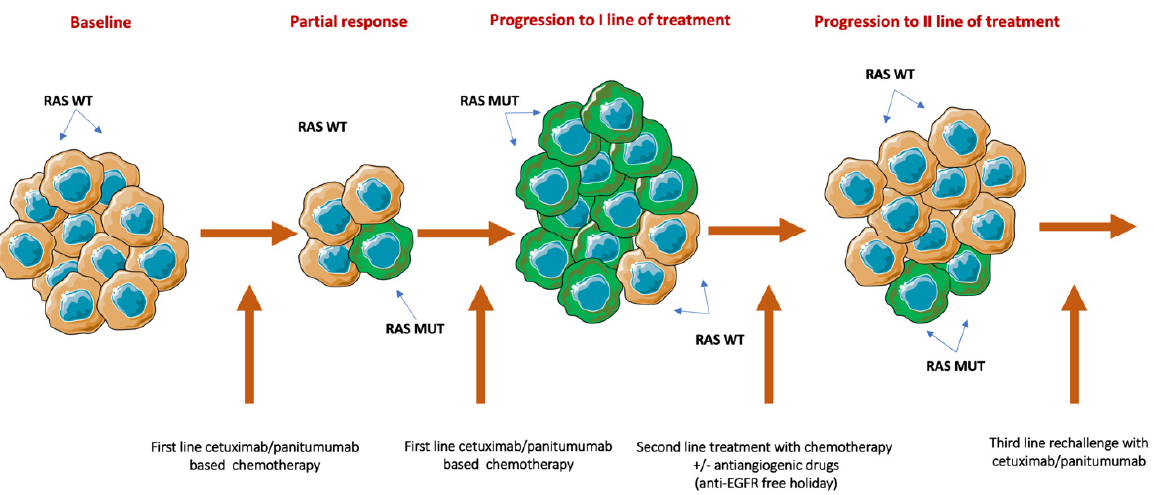
Figure 1. Biological rationale for rechallenge therapy. Treatment with anti-EGFR inhibitors rapidly eliminates RAS WT- sensitive clones and favors the expiation of resistant cancer cells. After disease progression, and due to the administration of a second line of chemotherapy without anti-EGFR monoclonal antibodies, RAS mutant clones progressively decay, inducing the proliferation of RAS WT cell. WT: Wild type; MUT: Mutant; /: Or.